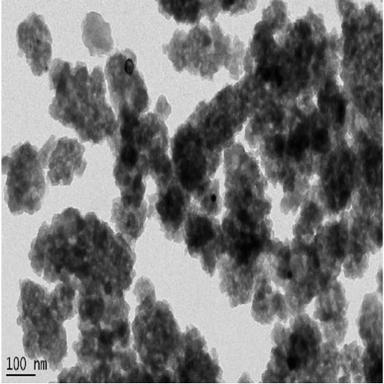
TEM image and histogram of nanoparticles for a) Red-C-Fe4.0HAlBEA and b) Red-C-Fe4.0SiBEA after calcination at 500 ◦C for 3 h and reduction at 900 ◦C.